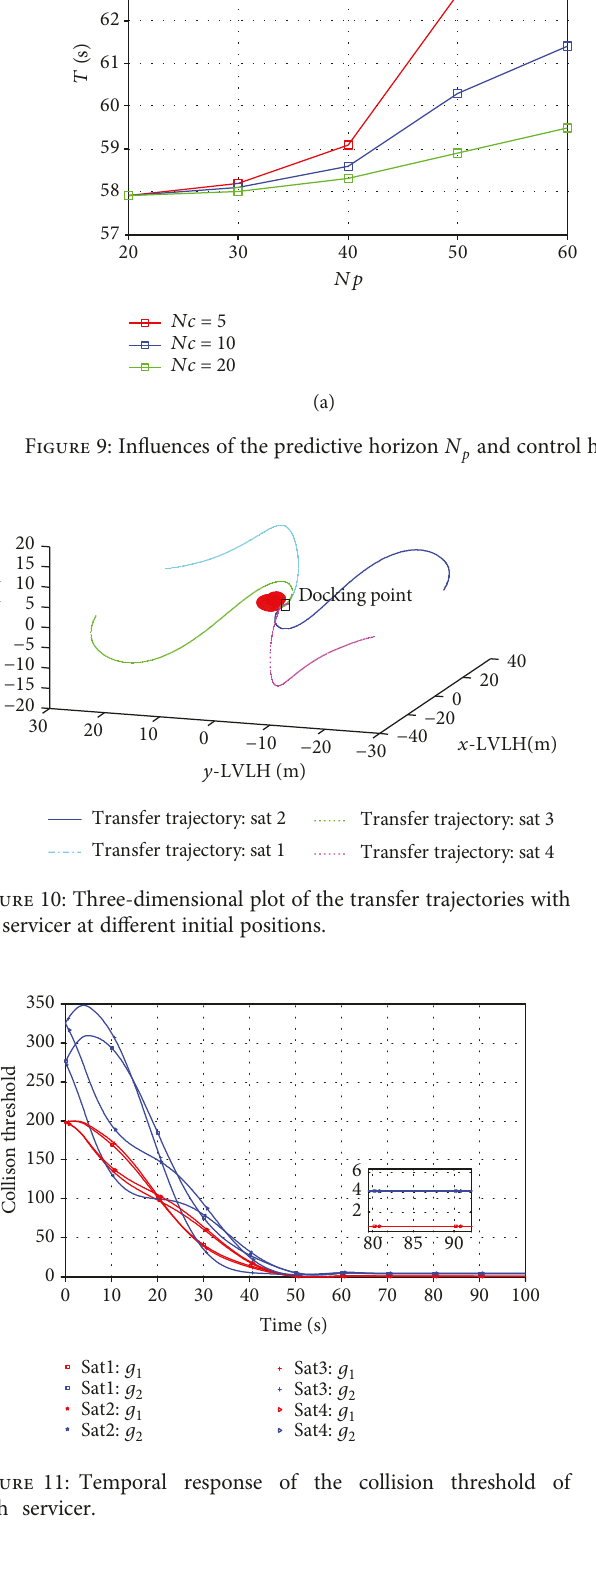
Figure 11: Temporal response of the collision threshold of each